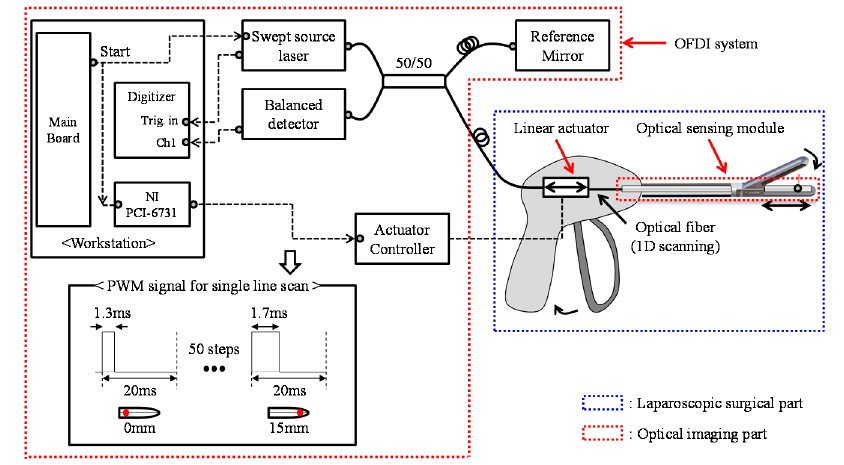
Figure 1. Schematic diagram of an image-guided laparoscopic surgical tool (IGLaST) based on the optical frequency domain imaging (OFDI) technique.